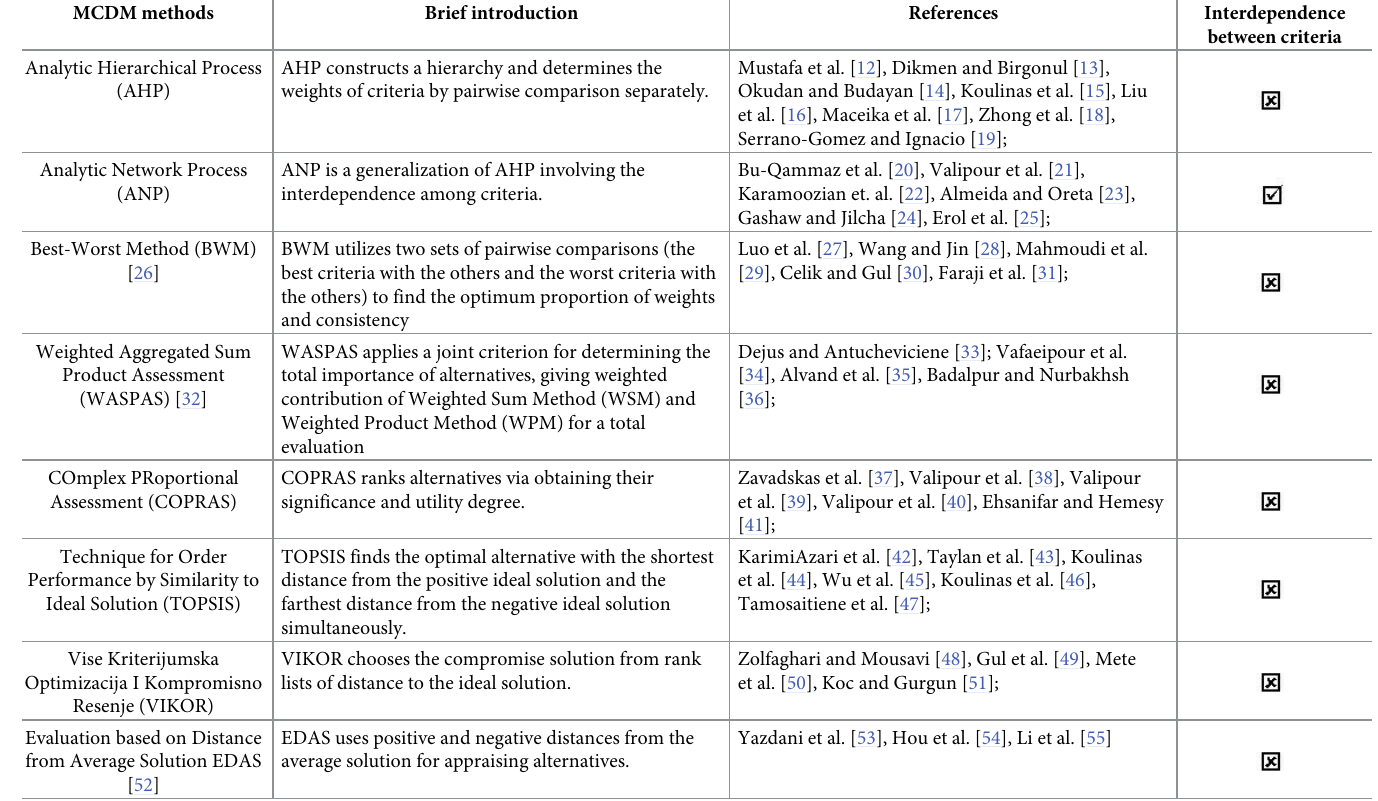
Table 1. Application of MCDM methods for risk assessment in construction